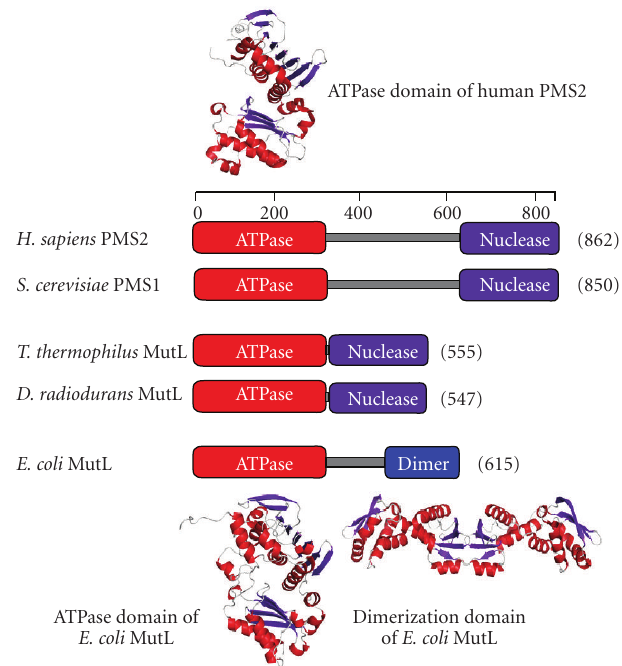
Figure 7: (a) A schematic representation of the domain structure of MutL homologues. ATPase, nuclease, and dimer indicate the ATPase, endonuclease, and dimerization domains, respectively. The crystal structures of N-terminal ATPase domain of human PMS2 (PDB ID: 1EA6) [45], ATPase domain of E. coli MutL (PDB ID: 1B63) [46], and C-terminal dimerization domain of E. coli MutL (PDB ID: 1X9Z) [47, 48] are